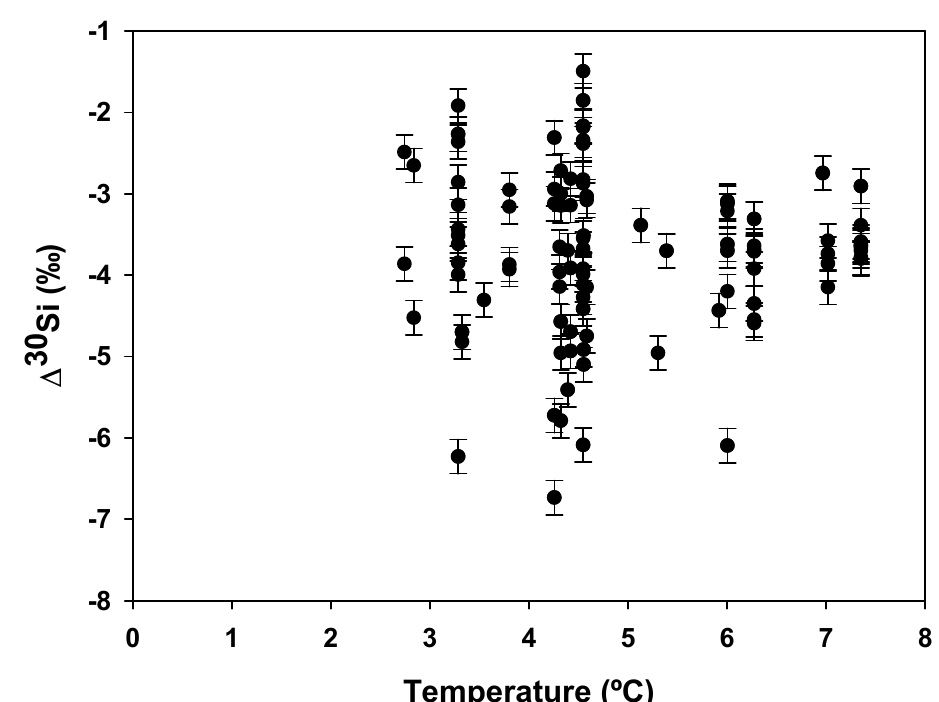
Figure A1. Apparent Si isotopic fractionation ( δ 30 Si) of deep sea sponges from the equatorial Atlantic against the ambient seawater temper-